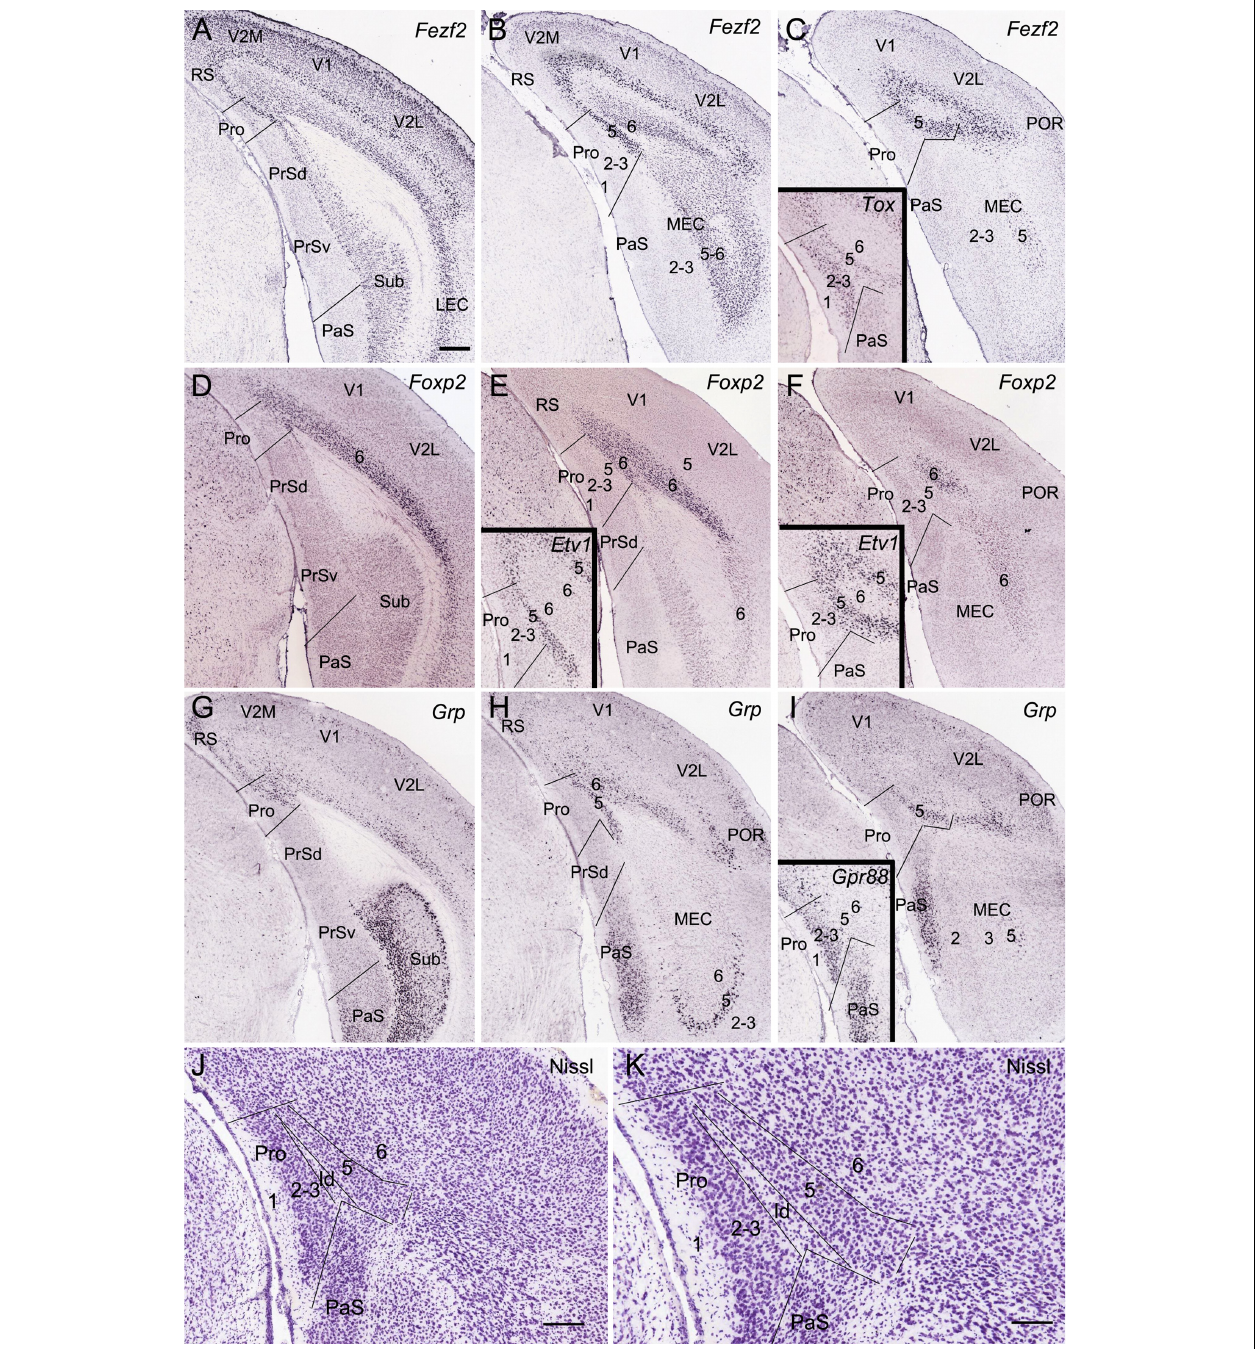
FIGURE 1 | Location topography of mouse prostriata (Pro). Panels (A–I) and all the insets are ISH-stained sections, while panels (J) and (K) are Nissl-stained sections. Arabic numerals indicate cortical layers. (A–C) Three rostral (A) to caudal (C) coronal sections showing Fezf2 expression in the Pro and adjoining regions. Strong Fezf2 expression is mainly seen in layers 5 and 6 (L5–6) of the Pro, retrosplenial (RS), presubiculum (PrS), medial entorhinal cortex (MEC), and lateral entorhinal cortex (LEC) and neocortical regions (V2M, V1, V2L, and POR) as well as in the Sub. L2–3 of the visual cortices also show faint expression. The inset in panel (C) shows Tox expression in L2–3 and L5 of the Pro. (D–F) Three rostral (D) to caudal (F) sections showing Foxp2 expression in L6 of the Pro and adjoining cortical regions. The insets in panels (E,F) show Etv1 expression in L5 of the Pro and adjoining regions. (G–I) Three rostral (G) to caudal (I) sections showing Grp expression in the Pro and adjoining regions. Strong Grp expression is observed in L5–6 of the Pro, L2 of the RS, ventral part of the PaS, L5 of the MEC, and L2–3 and L5 of the postrhinal cortex (POR) as well as in the Sub. The inset in panel (I) shows Gpr88 expression in the PaS and L2–3 of the Pro. (J,K) Cytoarchitecture and layers of the Pro shown at lower (J) and high (K) magnifications of a Nissl-stained section. Note the cell-sparse lamina dissecans (ld) separating L2–3 from L5 of the Pro. For abbreviations see the list. Bar: 350 µ m in panel (A) (for A–I and all insets); 210 µ m in panel (J) ; 130 µ m in panel (K) .